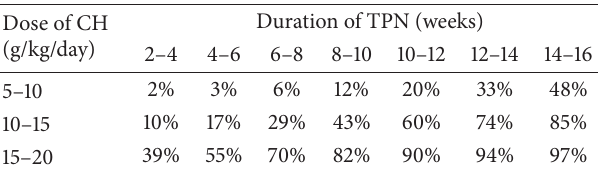
Table 4: Probability of cholestasis predicted by logistic regression model including duration of TPN and dose of